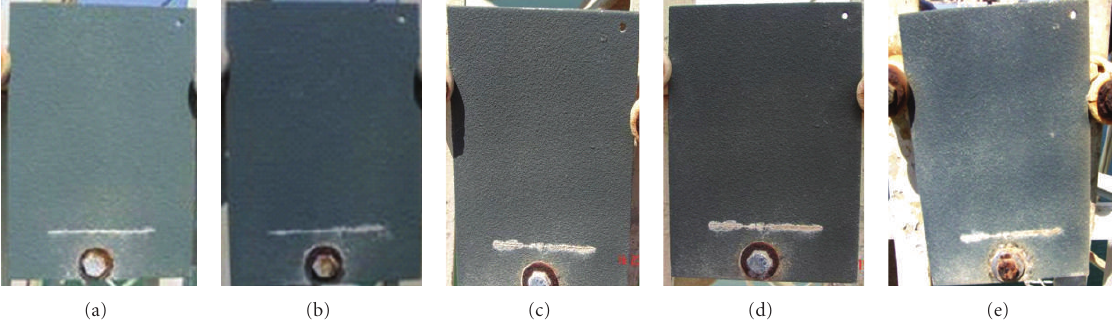
Figure 7: Thermal-sprayed coating of Zn/Al, sealed with wash primer 1 (345 μ m). (a) 12 months of exposure. (b) 24 months of exposure. (c) 36 months of exposure. (d) 41 months of exposure. (e) 71 months of exposure.